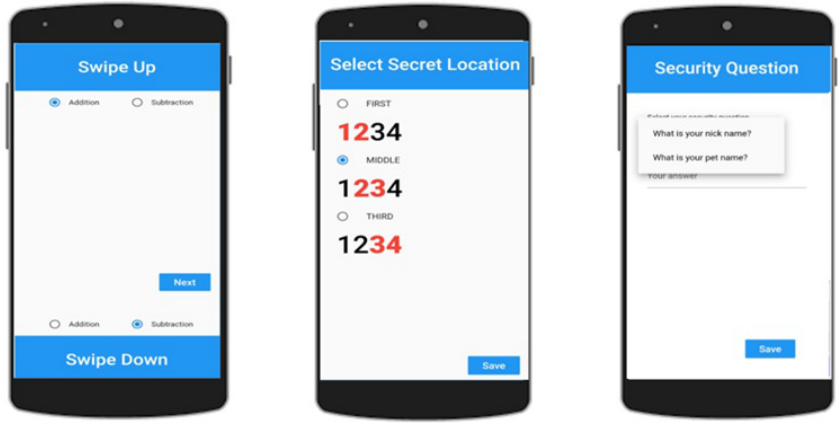
Figure 3. Select arithmetic operation, secret position, and security